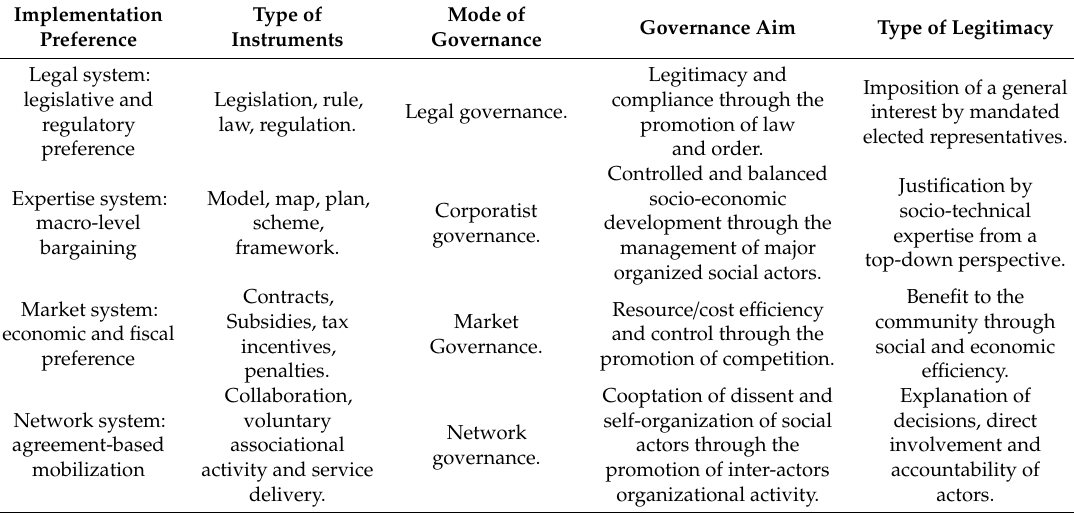
Table 1. From the choice of instruments to the legitimacy of